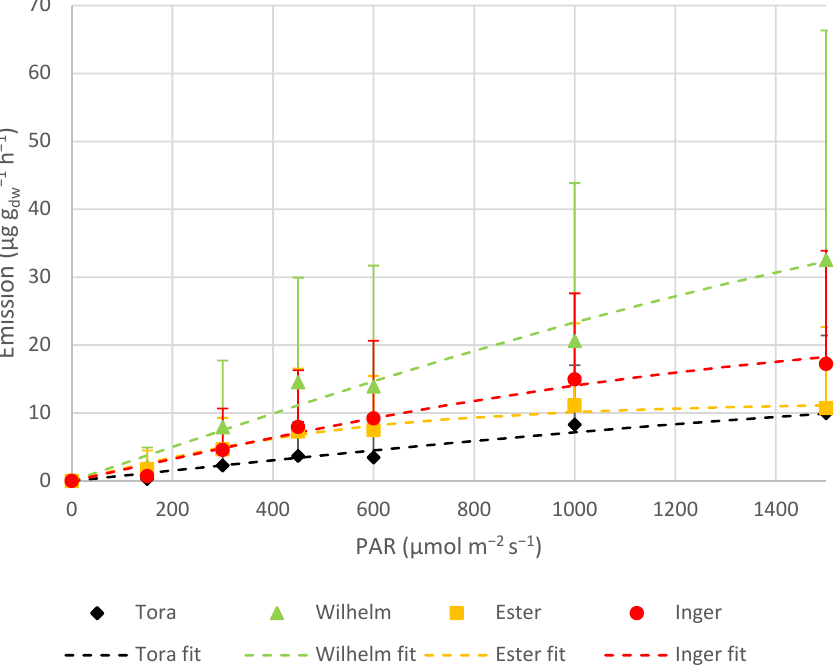
Figure 6. Isoprene emission rates (µg g dw − 1 h − 1 , mean + standard deviation, n = 7–16) and fitted curves according to Equation (2) for the Salix varieties at different PAR values (µmol m − 2 s − 1 ). Monoterpenes